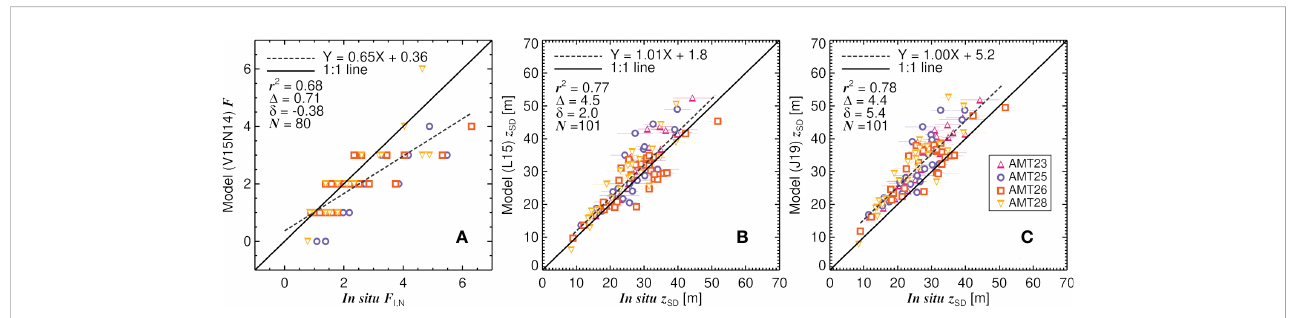
FIGURE 7 Comparison of R rs -derived Forel-Ule colour ( F ) and Secchi depth ( z SD ) with in-situ data. (A) R rs -derived F using the methods of van der Woerd and Wernand (2015) and Novoa et al. (2014) (V15N14) with in-situ F I,N ( F measured using the scale of Novoa et al. (2014) for the colour of the disk at half the Secchi depth, but converted to in fi nite colour using the method of Pitarch (2017)). (B) R rs -derived z SD using the model of Lee et al. (2015) (L15) against in-situ z SD . (C) R rs -derived z SD using the model of Jiang et al. (2019) (J19) against in-situ z SD . r 2 is the squared Pearson correlation coef fi cient, d the mean difference (bias), D the unbiased root mean square difference, and N the number of